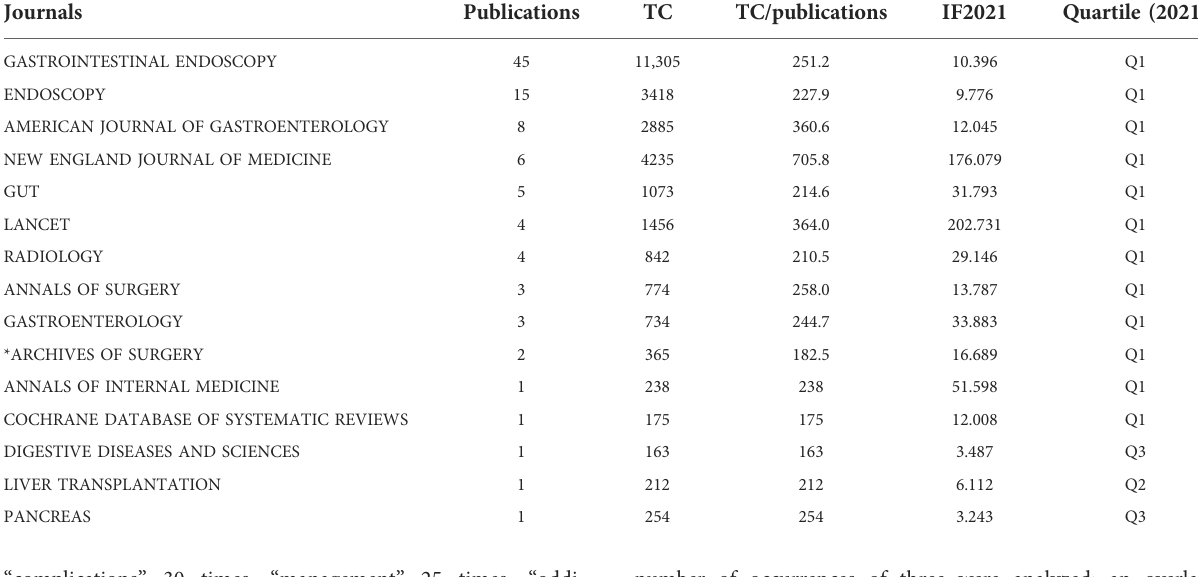
TABLE 4 Journals of top-cited articles.TC=total citations, IF=impact factor. *In 2013 ARCHIVES OF SURGERY changed to JAMA Surgery.